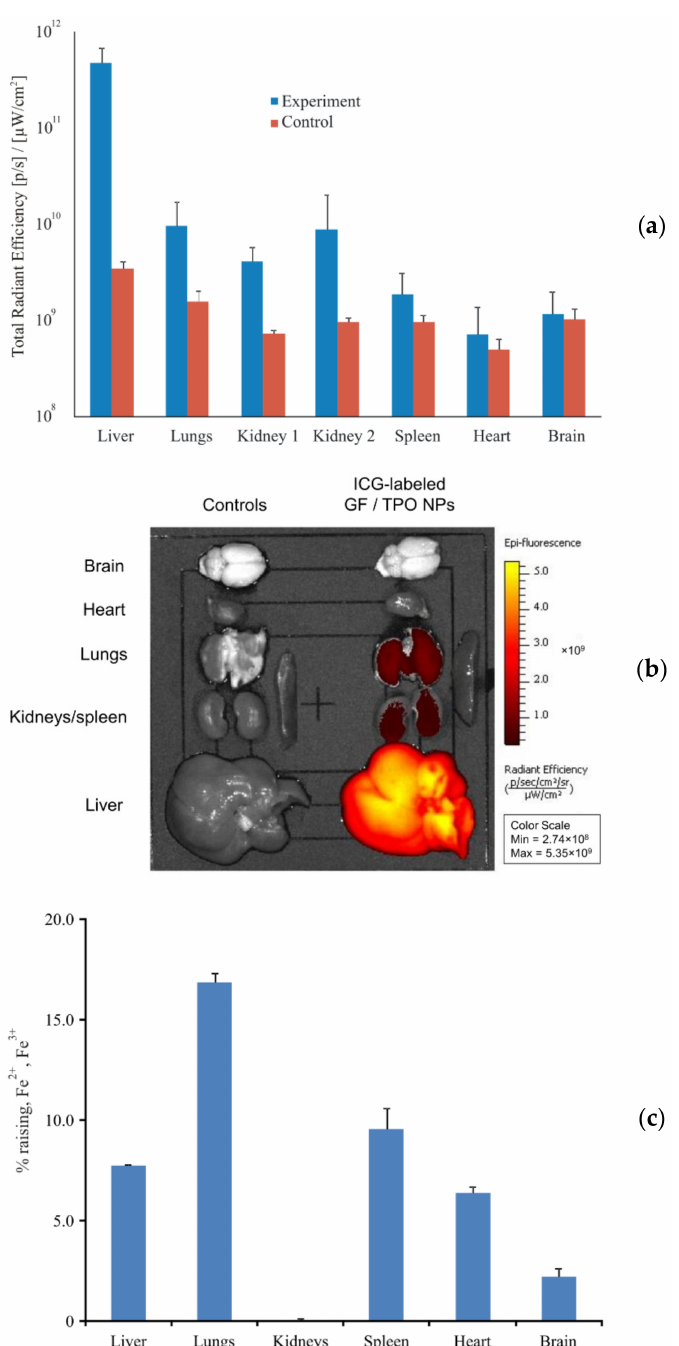
Figure 9. The results of in vivo biodistribution studies. ICG-labeled GF/TPO NPs in suspen- sion at a concentration of 2 mg/mL were injected into the tail vein of rats in a volume of 1 mL ( n = 5). 1 mL of saline solution was injected into the controls ( n = 5). After 30 min, the animals were euthanized followed by harvesting of main organs. The extent of nanoparticle accumulation in different organs was evaluated by either fluorescent imaging or quantification of tissue iron content: ( a ) Biodistribution of GF/TPO NPs with ICG; ( b ) Representative images of organs harvested from control animals and animals injected with ICG-labeled GF/TPO NPs. On the left row, the organs harvested from controls are shown, while on the right row the organs obtained from experimental group are demonstrated; ( c ) An increase in the quantity of iron cations in organs in relation to the